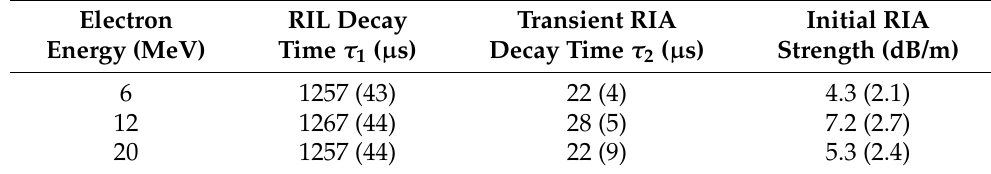
Figure 10. Fitted luminescence decay times ( top ), and transient RIA decay (luminescence buildup) times ( bottom ) at different depths of acrylic for 12 MeV electrons, with the estimated standard deviation of the fitted variable value as the error bars. The average of the measured values is shown with dotted lines, with the estimated standard deviations of the averages in parentheses. Table 1. Decay times of the luminescence at the main Gd 3 + -ion RIL at 314 nm under irradiation with electrons at a normal incidence angle. Fitted decay time values, transient RIA time constant, and RIA strength after the electron bunch are listed. The presented values are the average of the fitted ones at different depths of acrylic, with the estimated standard deviation in